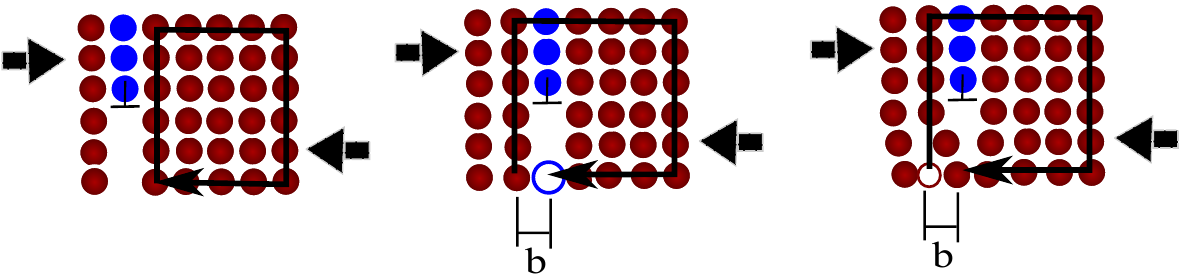
Figure 4. Ilustration of the concept of incompatibility through a moving dislocation. ( Left ) circuit is closed, locally compatible. ( Center ) plastic flow (e.g., a dislocation movement) produces an incompatible field, because the circuit is not closed by the amount b . ( Right ) Elastic deformations bring the field